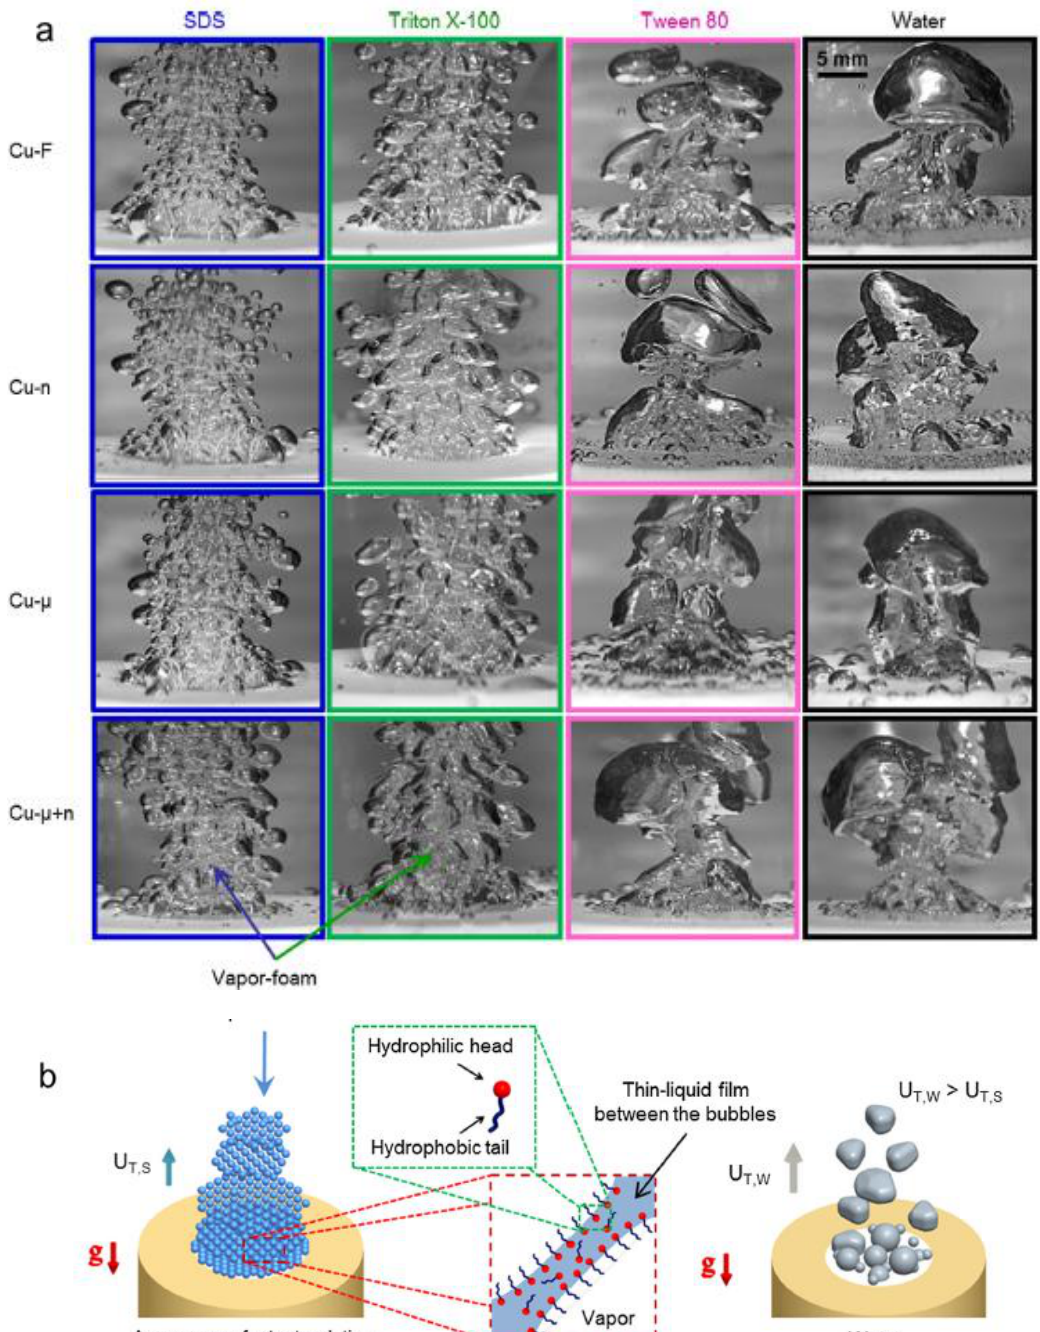
Figure 14. ( a ) Snapshot of bubbles during near-saturated boiling with aqueous surfactant solutions at critical micelle concentration and pure water in the early nucleate boiling regime. ( b ) Schematic representation of the bubble behavior during pool boiling. Relatively large bubbles with higher terminal velocity were formed with water in comparison to surfactant solution [134].